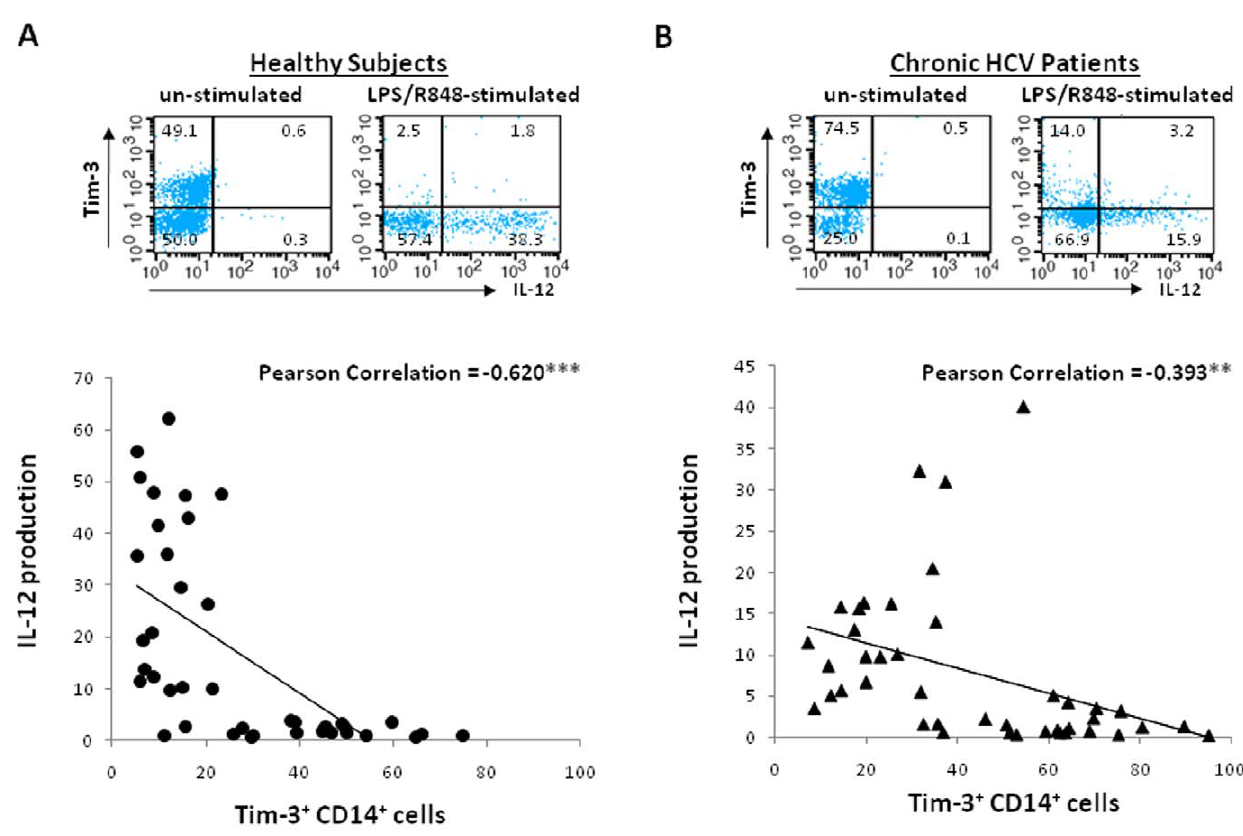
Figure 2. Tim-3 expression is inversely associated with IL-12 production in M/M Ø . Tim-3 expression and IL-12 production in CD14 + M/M Ø were measured by flow cytometry triple immunostaining in healthy subjects (A) and chronically HCV-infected individuals (B). Representative dot plots to show the relationship of Tim-3 and IL-12 expressions in CD14 + M/M Ø in un-stimulated and TLR-stimulated are shown above. The correlation between Tim-3 expression and IL-12 production in M/M Ø , evaluated by Pearson Correlation with 2-tailed significance (** , 0.01, *** , 0.001) denoted in the upper right corner of each analysis, is shown below.